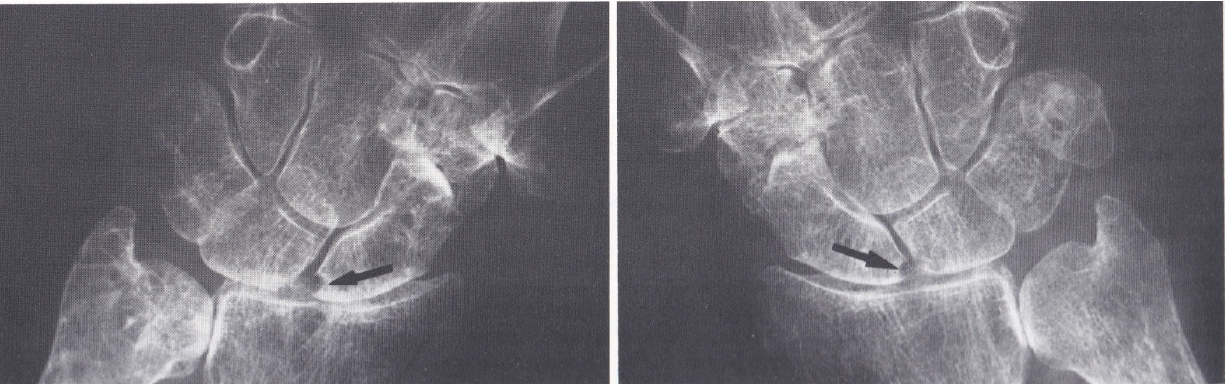
Figure 2. Bilateral and symmetrical erosions of the scaphoid bones. Table 1. Main laboratory data at the time of RA diagnosis.